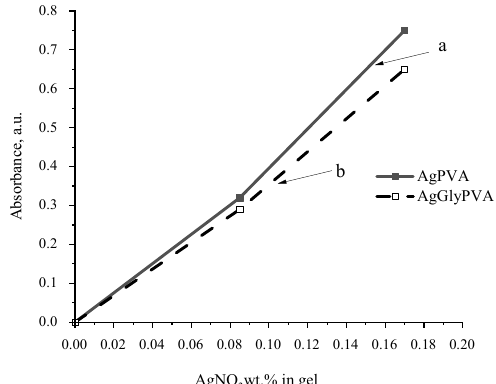
Figure 4. The influence AgNO 3 concentration on LSPR intensity in irradiated PVA composites: (a) without glycerol (AgPVA); (b) containing some amount of glycerol (AgGlyPVA). The red shift of LSPR band with the increased amount of silver salt in the initial PVA samples indicates that with the increased silver ion concentration, silver nanoparticles that are dispersive in size are produced and particle agglomeration is possible upon